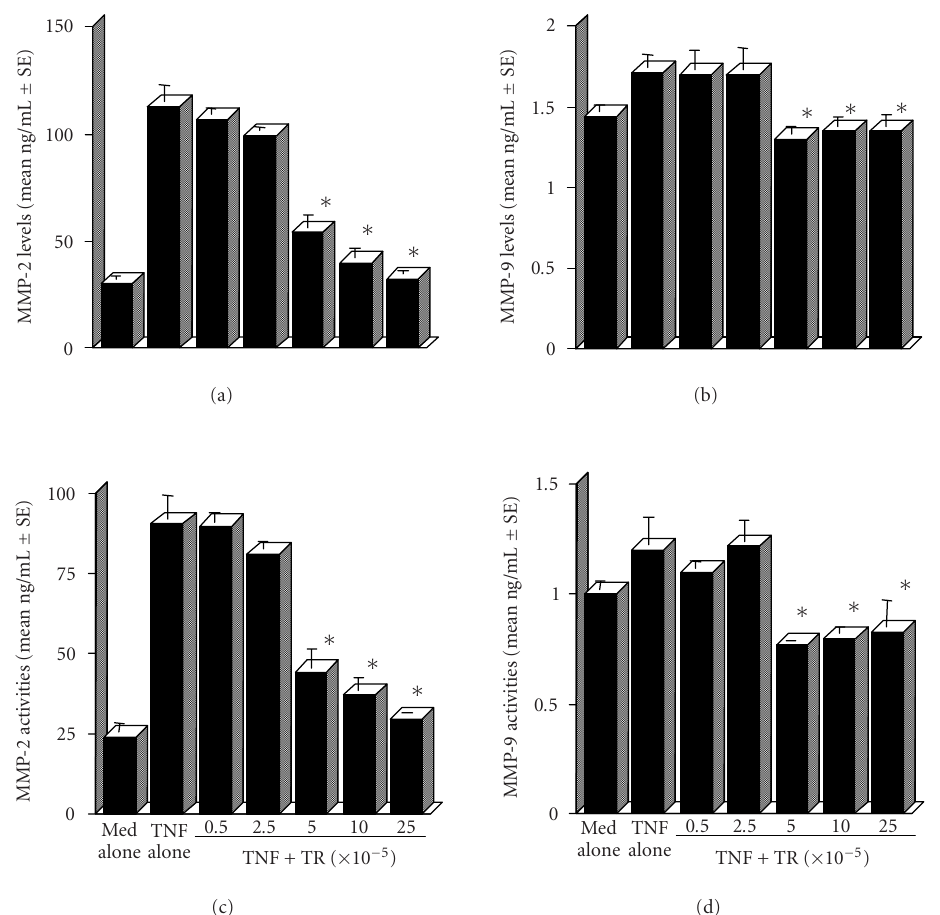
Figure 4. Influence of pretreatment of nasal fibroblast with tranilast (TR) on the production of MMP-2 and MMP-9 and their activities. Cells were treated with various concentrations of TR for 2 hours and then stimulated with TNF- α (TNF) for 24 hours. Data are expressed as the mean ng/mL ± SE of five di ff erent subjects. ∗ means significant ( P < . 05) compared with TNF alone.